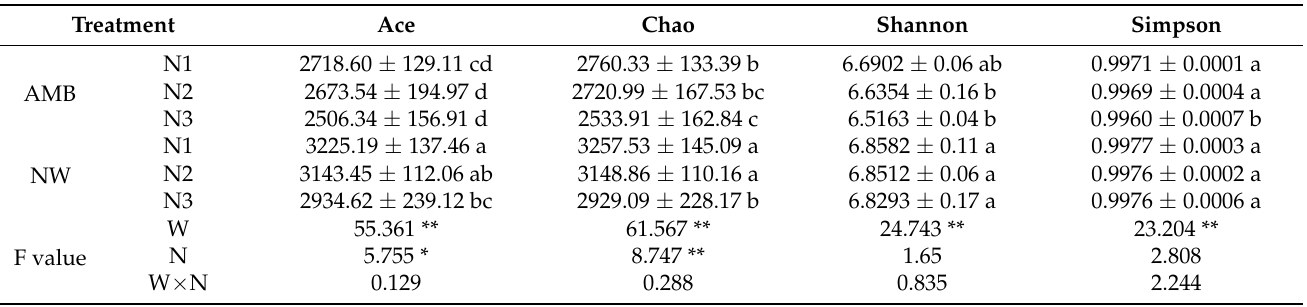
Table 2. Effects of nighttime warming and nitrogen application on the diversity index of the soil bacterial